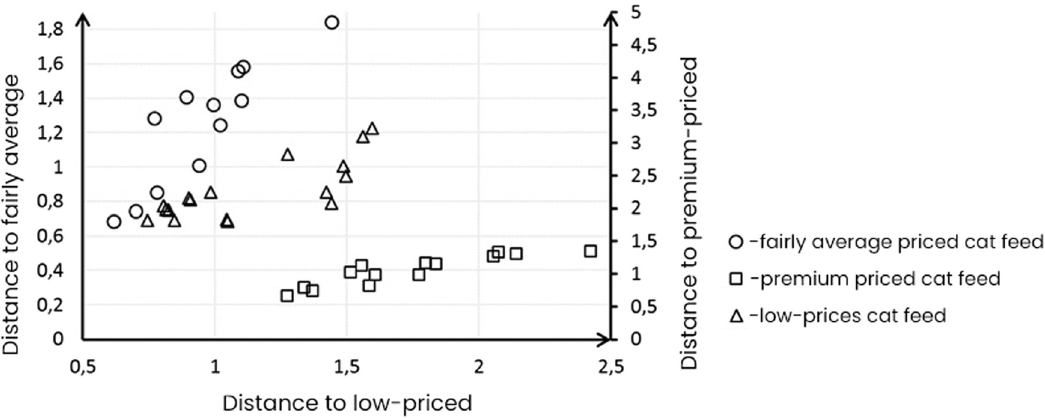
Figure 4: Graphical presentation of statistical Mahalanobis distances of low - priced ( triangles ) , fairly average priced ( circles ) and premium - priced ( rectangles ) cat feed samples from the group of fairly average, low - priced and premium - priced. Fairly average samples refer to the left y - axis ( distance to premium - priced is not presented ) while premium - priced samples refer to right y - axis ( distance to fairly average is not given ) . For not presented distances, see Table 2.